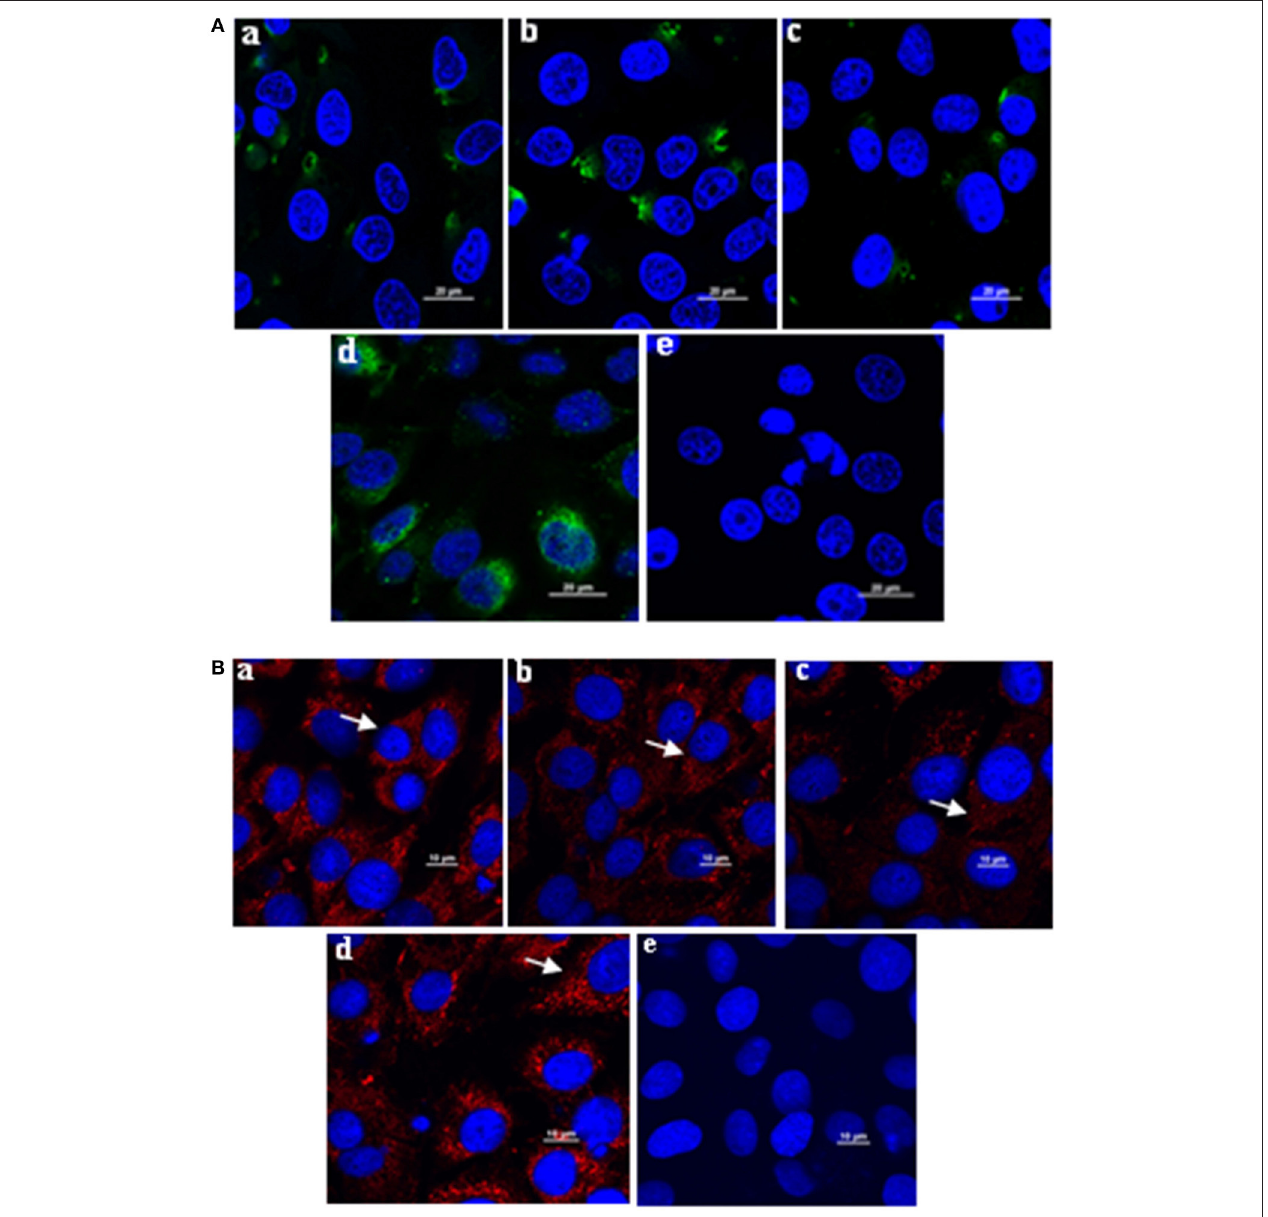
FIGURE 6 | Application of the monoclonal antibody in immunofluorescence assay to monitor the L. intracellularis in infected monolayer cells after incubated for 3h and 7 days, respectively. (A) L. intracellularis were incubated for 3h; the presence of L. intracellularis by IFA was stained green. (B) L. intracellularis were incubated for 7 days, the presence of L. intracellularis was stained red. Nuclei were counterstained with DAPI (blue). The mouse serum against Omp2 protein and unimmunized normal mouse serum were used as positive and negative control. (a) 4D9 MAb; (b) 3G2 MAb; (c) 7G5 MAb; (d) positive control; (e) negative control. × 600.